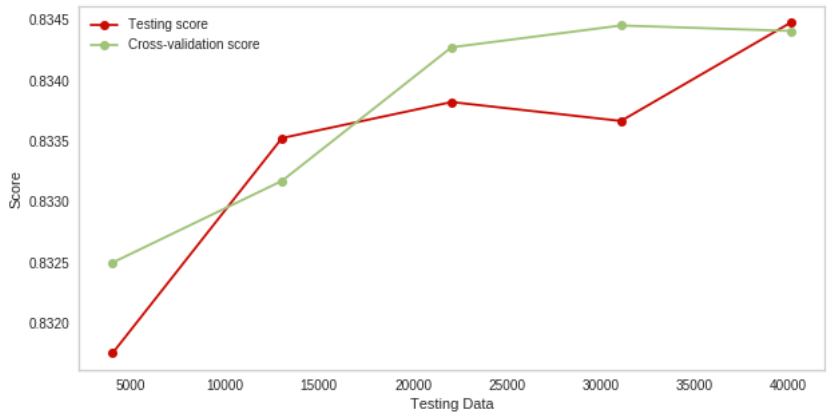
Figure 8. Naive Bayes testing learning curve.